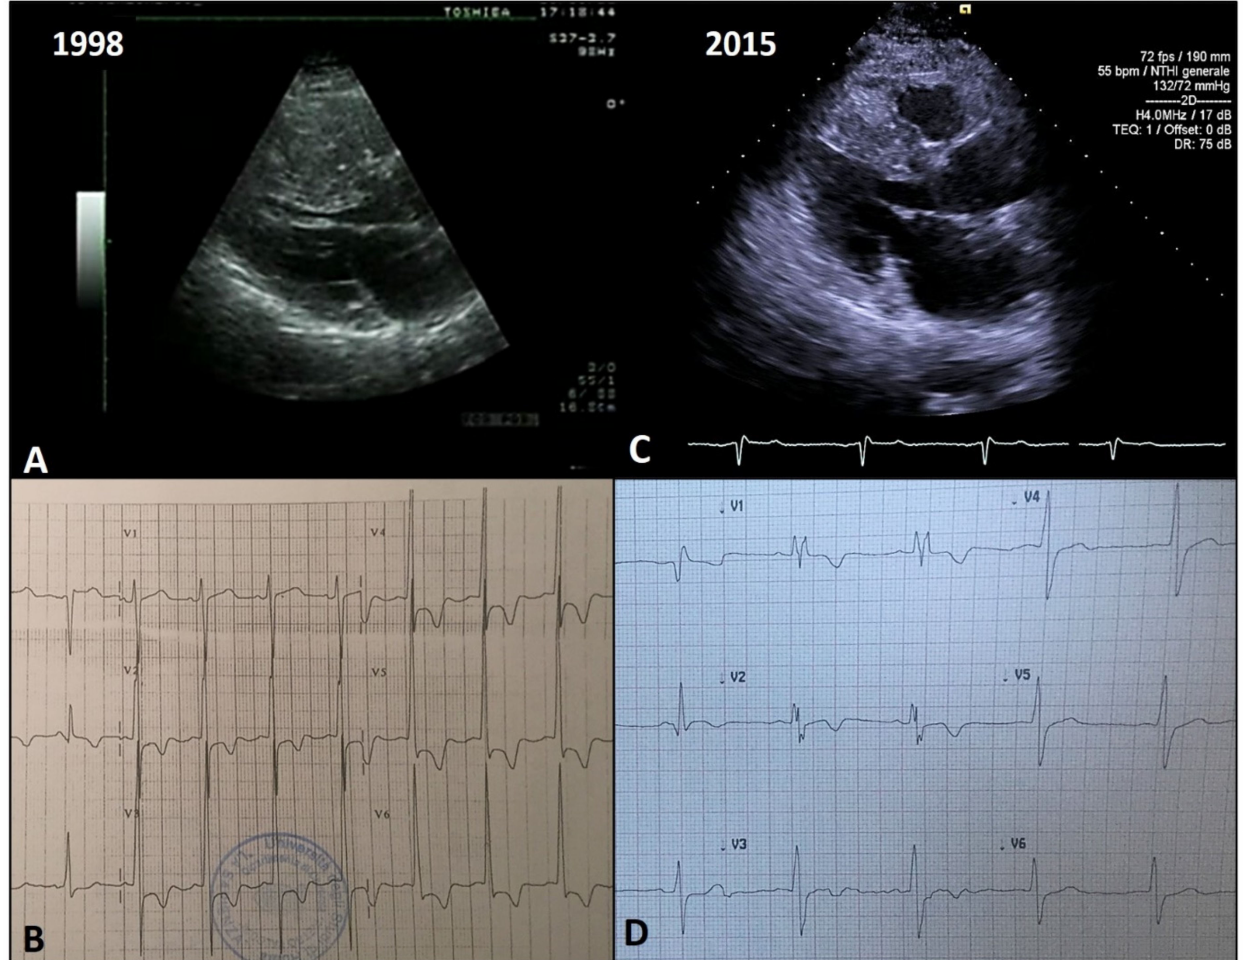
Figure 4. Echocardiographic and electrocardiographic findings in a patient with benign LV remodeling. A 49-year-old male patient received a diagnosis of non-obstructive HCM, with evidence of massive LV hypertrophy (maximal wall thickness of 37 mm at the level of the anterior septum ( A )) in the echocardiogram. The electrocardiogram showed signs of LV hypertrophy and inverted T wave in precordial leads ( B ). At that time, the patient was implanted with a cardioverter defibrillator for primary prevention. After 17 years, the echocardiogram showed a progressive, significant reduction in maximal LV wall thickness, up to 24 mm at the last evaluation ( C ). Concurrently, a reduction in QRS amplitude and an increase in QRS duration were noted in the electrocardiogram ( D ). His clinical conditions are stable and he has never experienced any implantable cardioverter defibrillator